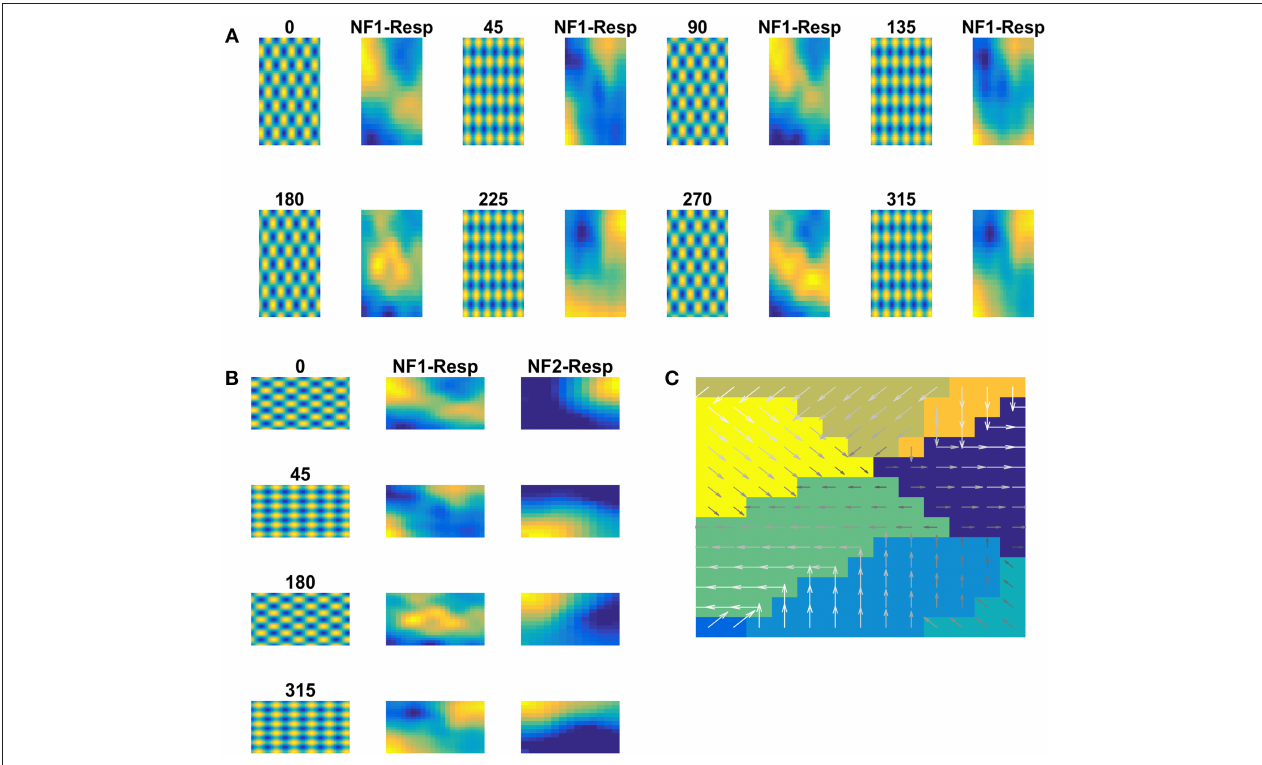
FIGURE 7 | Two-NFs network response to moving plaid stimuli. the Plaid (64 × 64 pixels) stimulus is created from its components (two gratings) and is allowed to move in 8 different directions. NF1 (analogous to V1) is trained with plaid components (i.e., moving gratings) and its response to moving plaid stimuli is plotted in (A) . First, third, fifth, and seventh columns display a frame in moving plaid sequence. The label above it indicates the direction of motion of a plaid. Second, fourth, sixth, and eighth columns represent the NF1 response to plaids, and two neuron populations are active in response to every moving plaid stimulus. As each plaid is composed of two gratings, neurons that are preferential to these moving gratings are becoming active. For example, the plaid moving in 315 ◦ is made from gratings moving in 270 and 0 ◦ . The activity pattern of these two plaid components (shown in Figure 6B ) gets integrated and produces a plaid response as two activity bubbles. NF2 (analogous to MT) is trained using plaid pattern moving in 8 directions, by keeping NF1 weights constant. The response of NF2 to four sample stimuli is shown in (B) . The first column represents frames of moving plaid stimuli, second and third columns labeled as NF1-Resp (20 × 20 units) and NF2-Resp (13 × 13 units) represents the responses of NF1 and NF2, respectively. We observed that in response to 8 moving plaid stimuli 8 different patches of neurons become selective to different directions of motion, and the corresponding pattern selectivity map is shown in (C)